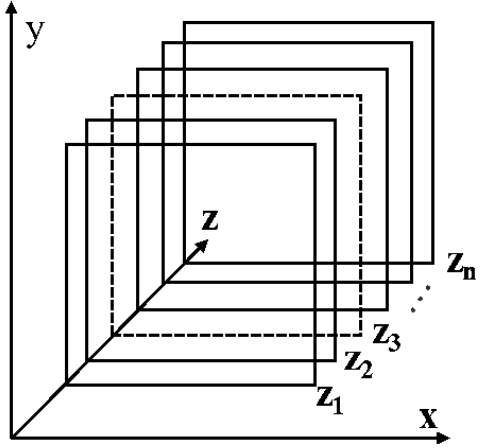
Figure 3. Range compressed data after 1DFFT is performed on the time axis of echo